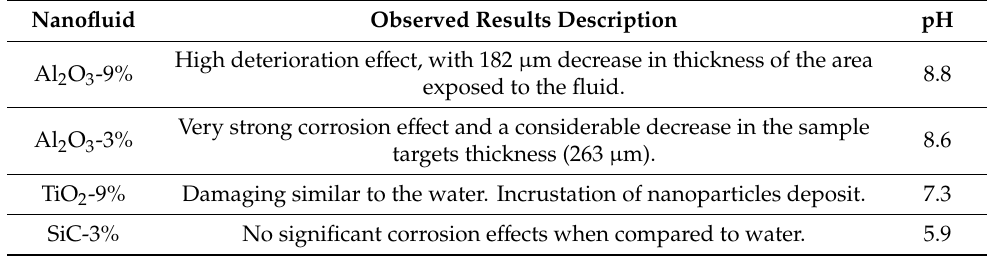
Table 3. Summary of the experimental results obtained for the aluminum sample targets